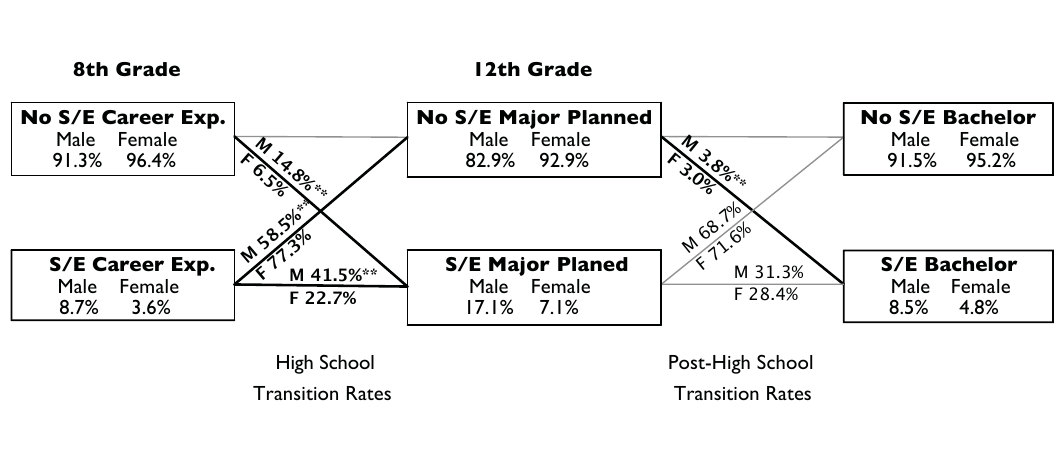
Figure 1: Pathways to a science and engineering BA degree (* p < 0 . 05 ; ** p < 0 . 01 ). percent compared to 22.7 percent and 14.8